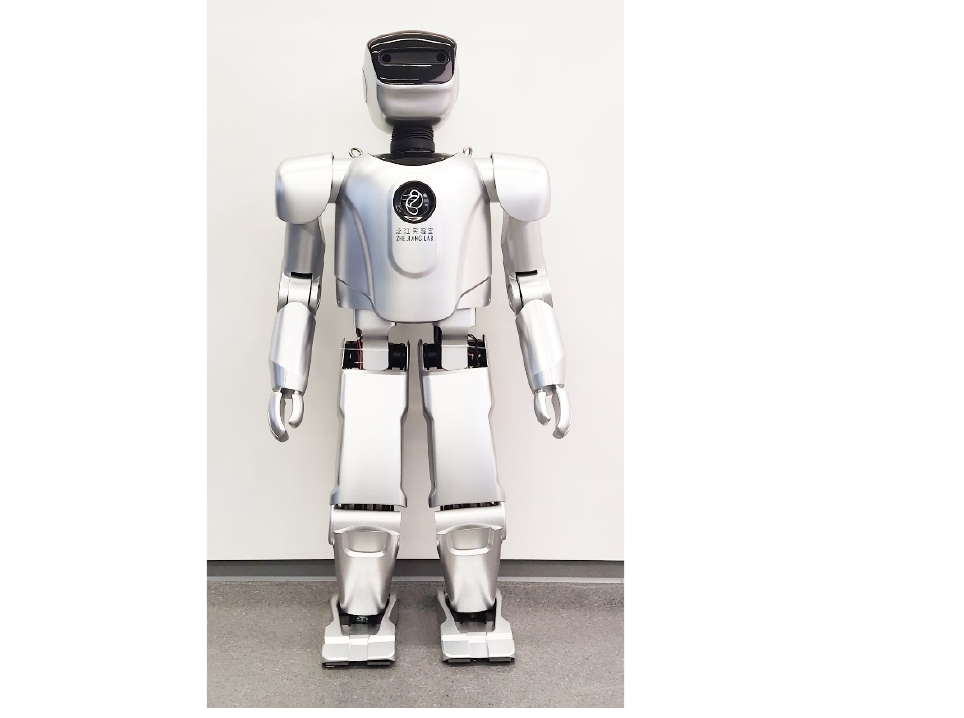
Figure 1. Biped robot AIRO built in Zhejiang Lab.